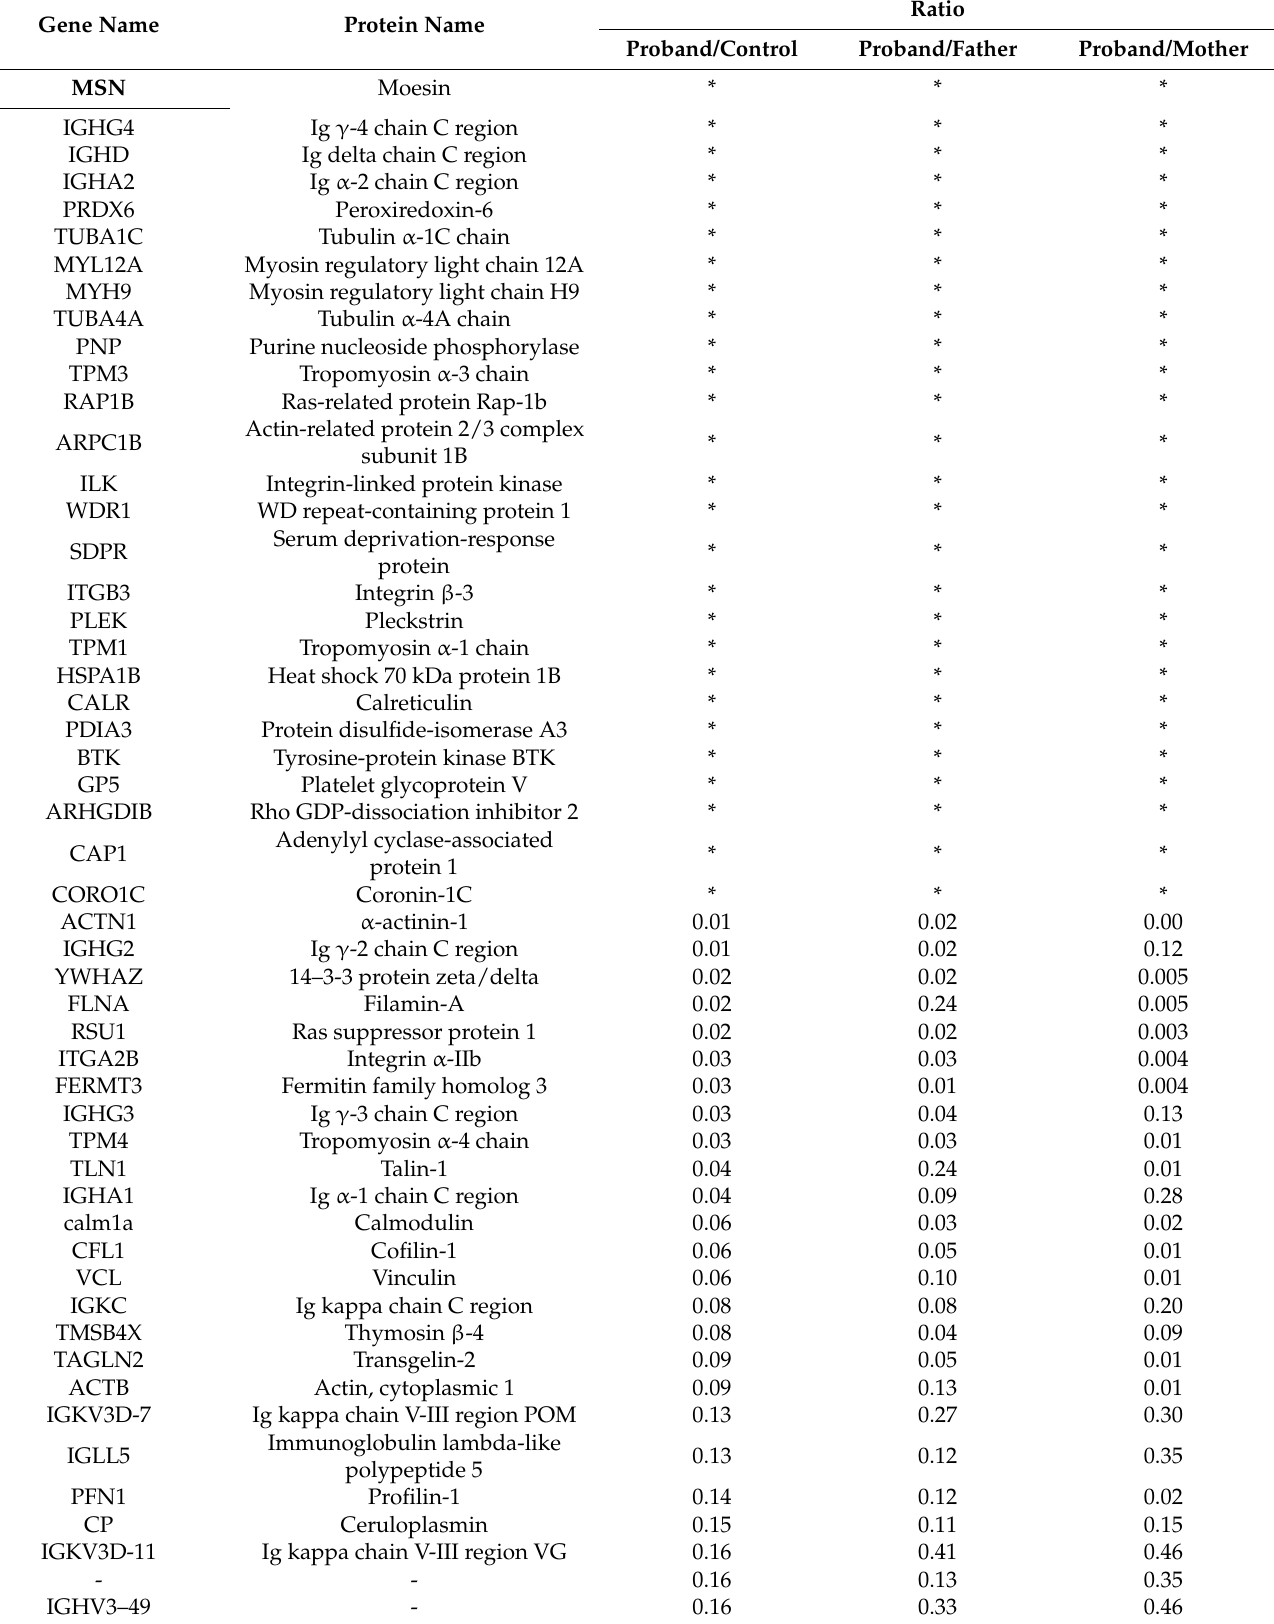
Table 4. Plasma proteins with differences between